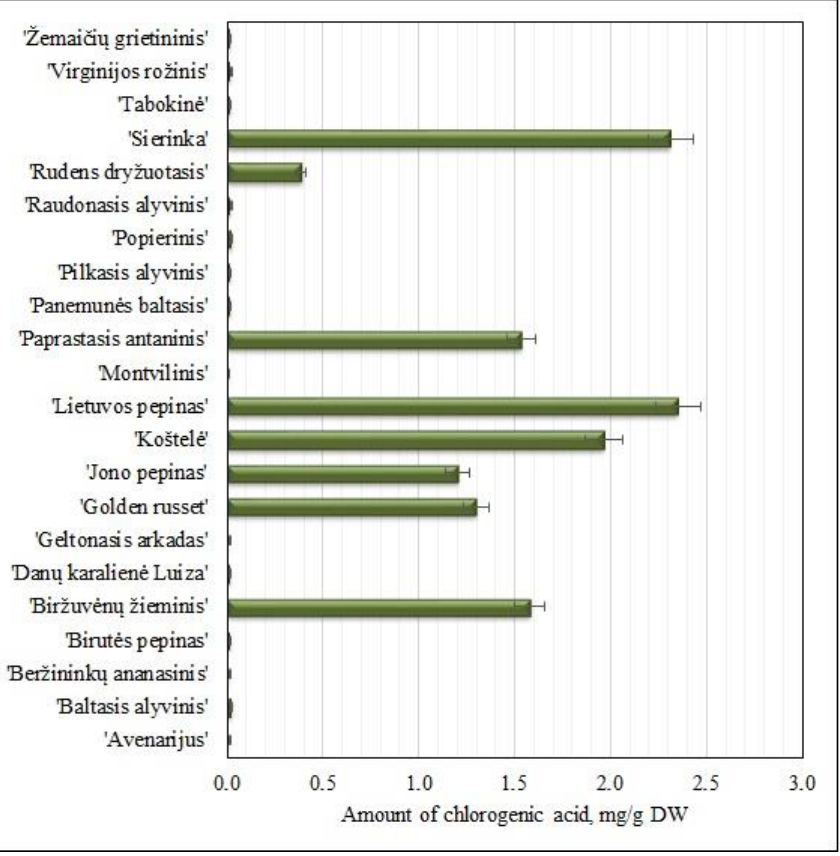
Figure 4 Figure 4. Variability of the amount of chlorogenic acid in fruit samples of heirloom apple cultivars. The highest amount of chlorogenic acid (2.35 ± 0.03 mg / g) was detected in apple fruit samples of the ‘Lietuvos pepinas’ cultivar (Figure 4). The content of chlorogenic acid in fruit samples of heirloom apple cultivars di ff ered statistically significantly ( p < 0.05). The lowest amount of